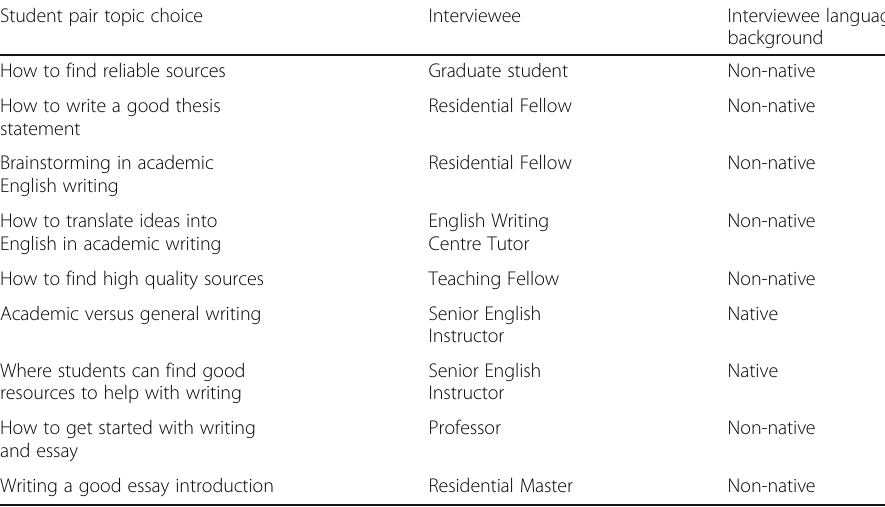
Table 2 Topic choices and interviewees Student pair topic choice